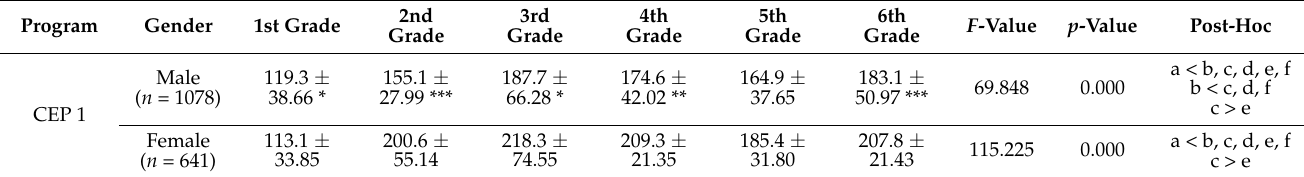
Table 3. Comparison of circuit exercise program 1 by grade and gender (Mean ± SD).